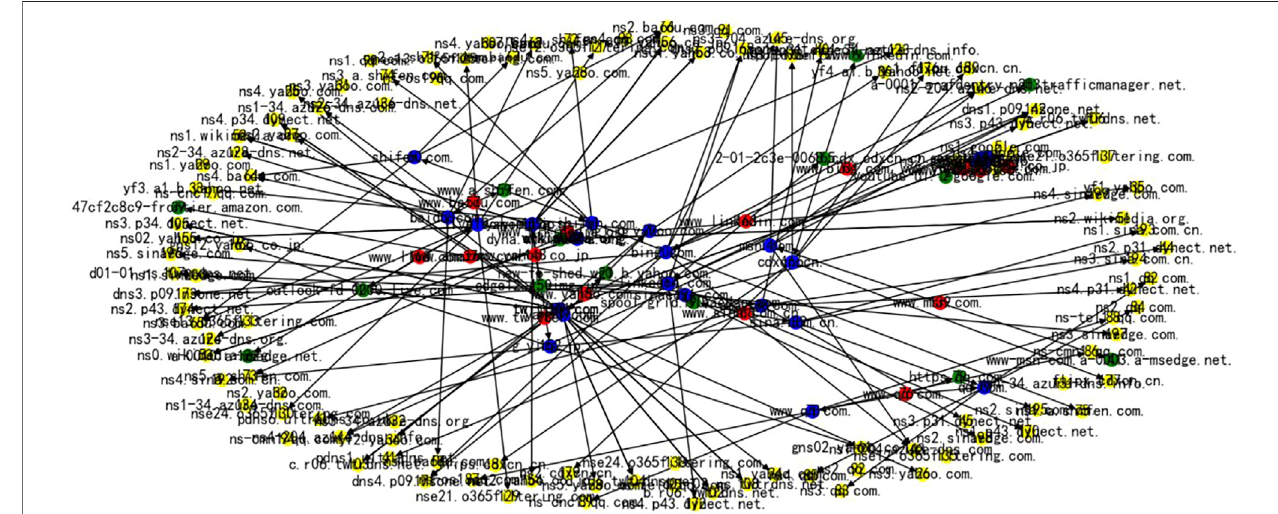
FIGURE 5 | An example of a domain name resolution network with 200